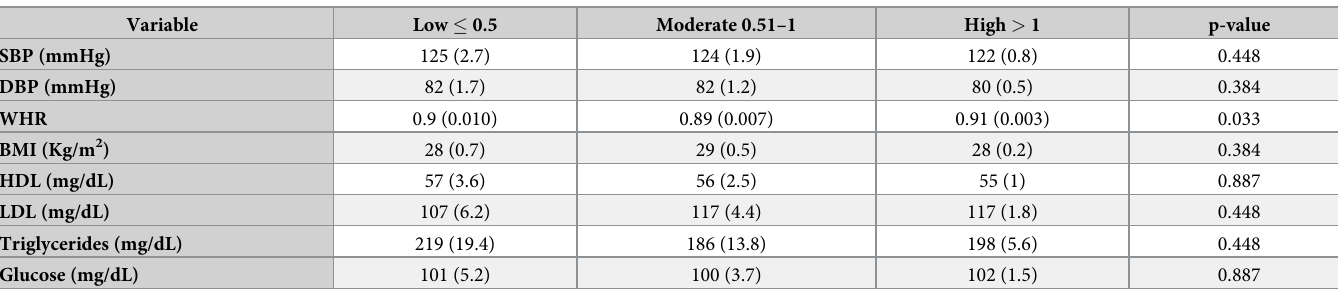
Table 3. Legume intake and metabolic syndrome clinical characteristics.